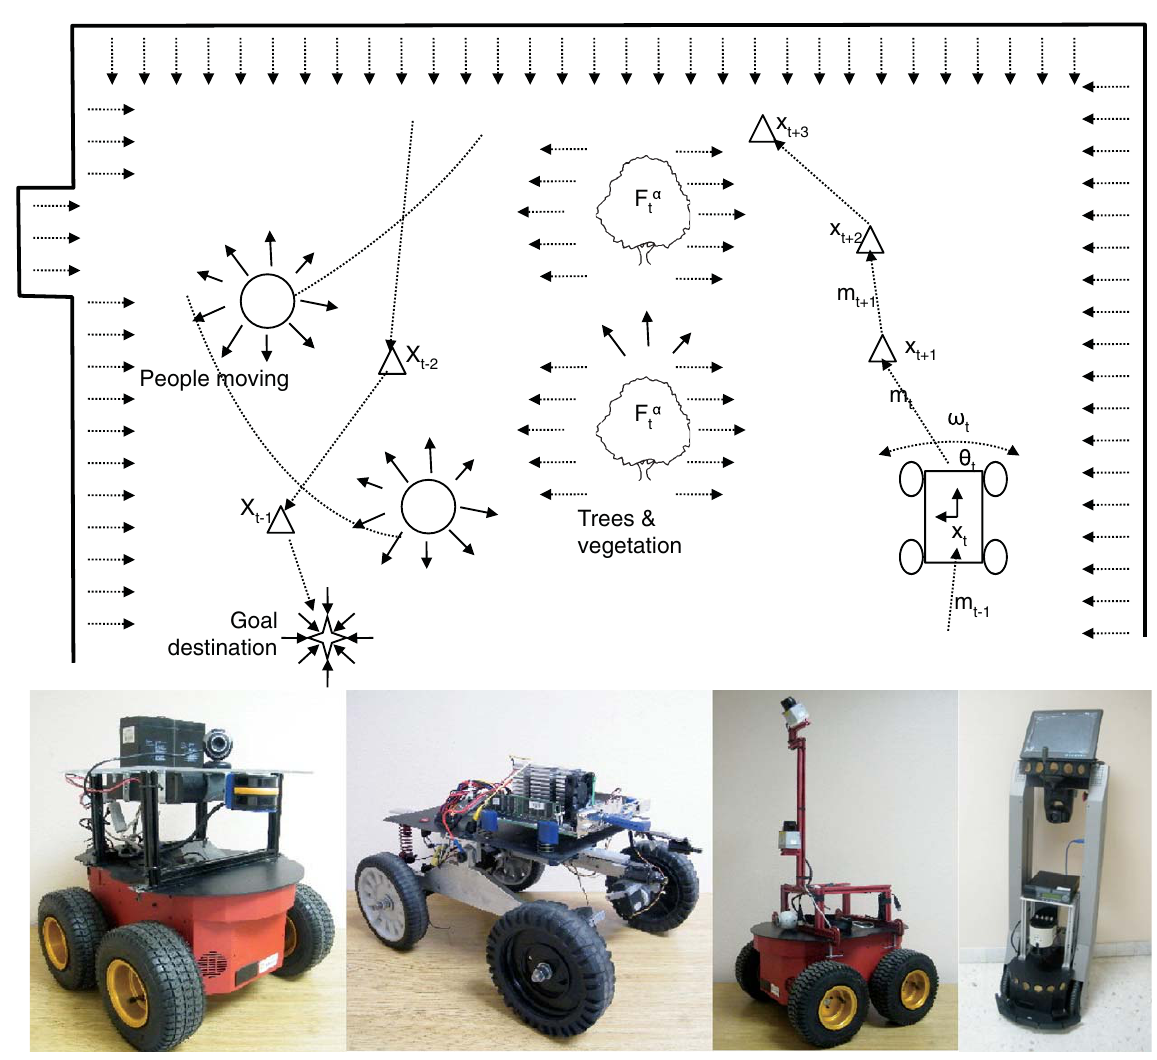
Fig. 1. Above: An outdoor environment with multiple static/dynamic obstacles and goals. Below: Different kinematic structures deployed with the approach. in different scientific communities, and was presented in a non-integrable form by Helbing and Molnar